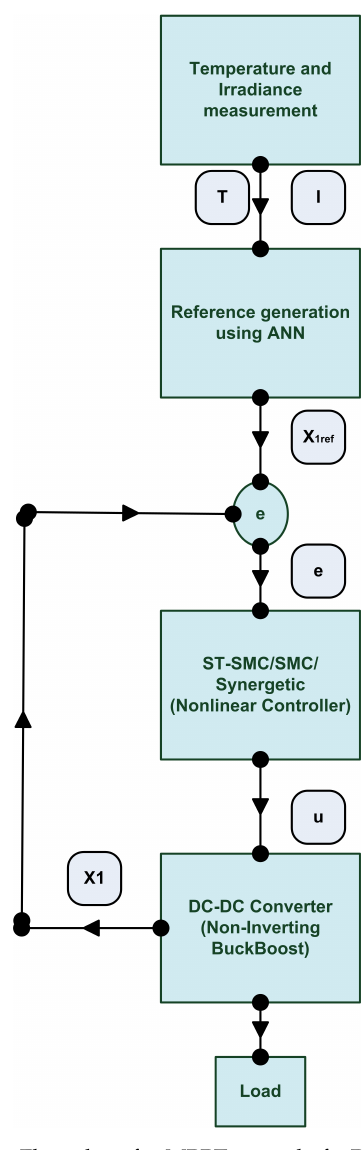
Figure 11. Flow chart for MPPT control of a PV system.